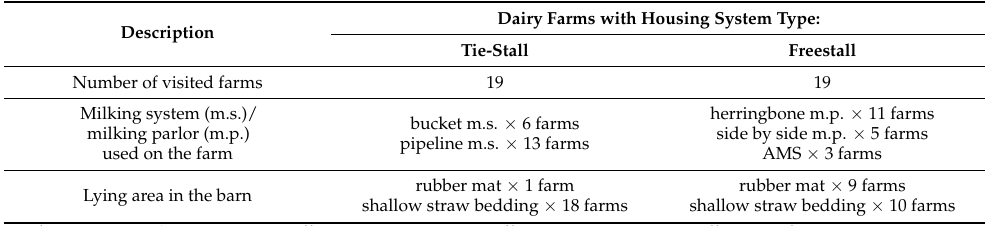
Table 2. Description of milking and lying areas in the investigated dairy farms. Dairy Farms with Housing System Type: Description Tie-Stall Freestall Number of visited farms 19 19 Milking system (m.s.)/ milking parlor (m.p.) used on the